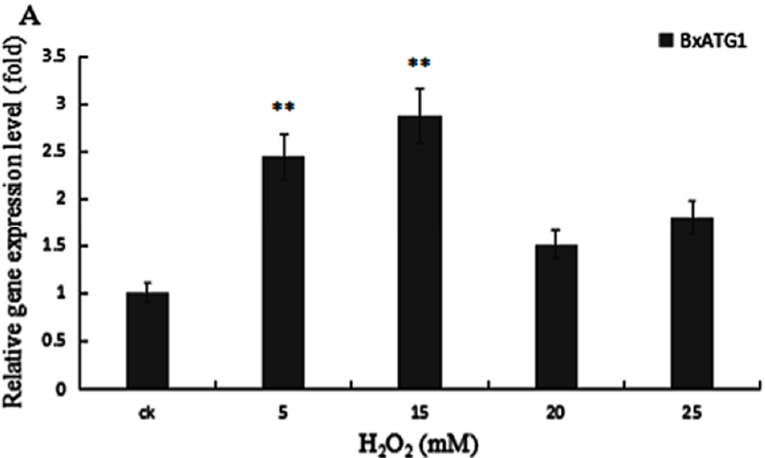
Figure 5. Cont. Figure 5. Cont.